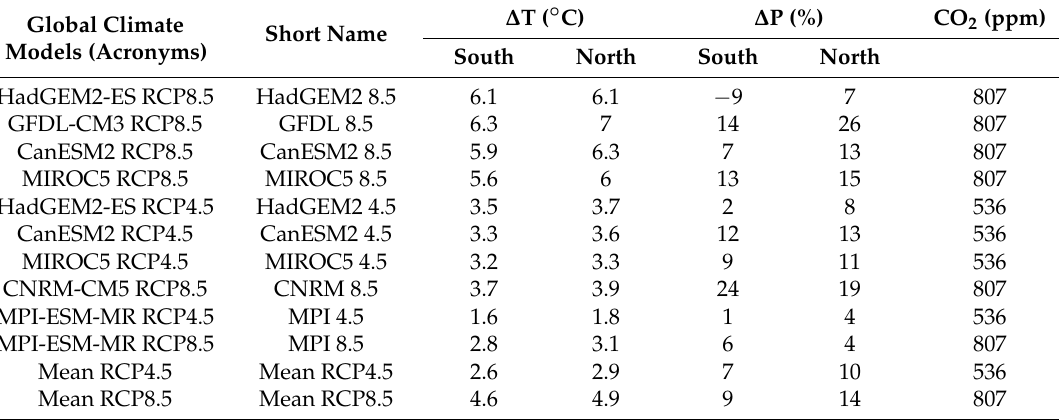
Table 2. Mean changes in temperature ( ∆ T, ◦ C) and precipitation ( ∆ P, %) during the potential growing seasons (April–September) in the period 2070–2099 in southern (old Forest Centre Units 1–6) and northern (old Forest Centre Units 10–13) Finland, in comparison to the current climate (1981–2010, with the mean CO 2 concentration of 360 ppm) and the predicted mean atmospheric CO 2 concentration (ppm), under the individual GCM runs. In the table, corresponding values are provided also for the multi-model mean values of 28 GCMs under the RCP4.5 and RCP8.5 forcing scenario (see the country of origin and other info for individual GCMs in